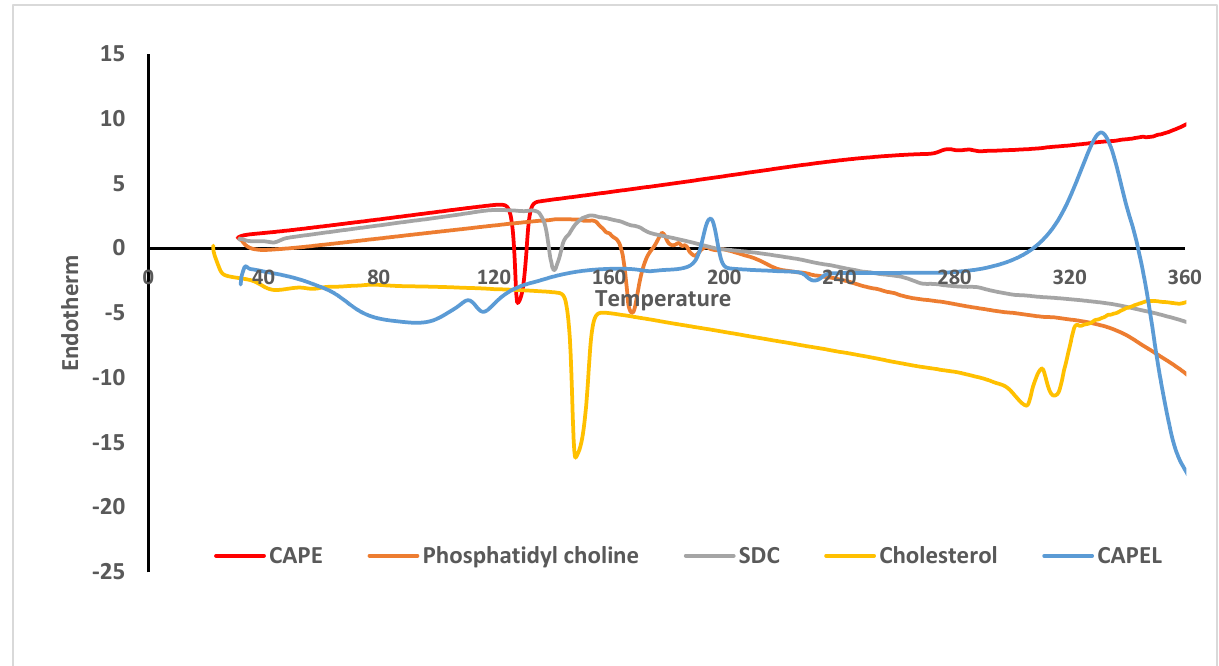
Figure 1. Differential scan calorimetry (DSC) thermogram of caffeic acid phenethyl ester (CAPE)- optimal liposomal formulation (CAPEL) in comparison to free caffeic acid phenethyl ester (CAPE), phosphatidyl choline, sodium deoxycholate (SDC) and cholesterol ( n = 1).